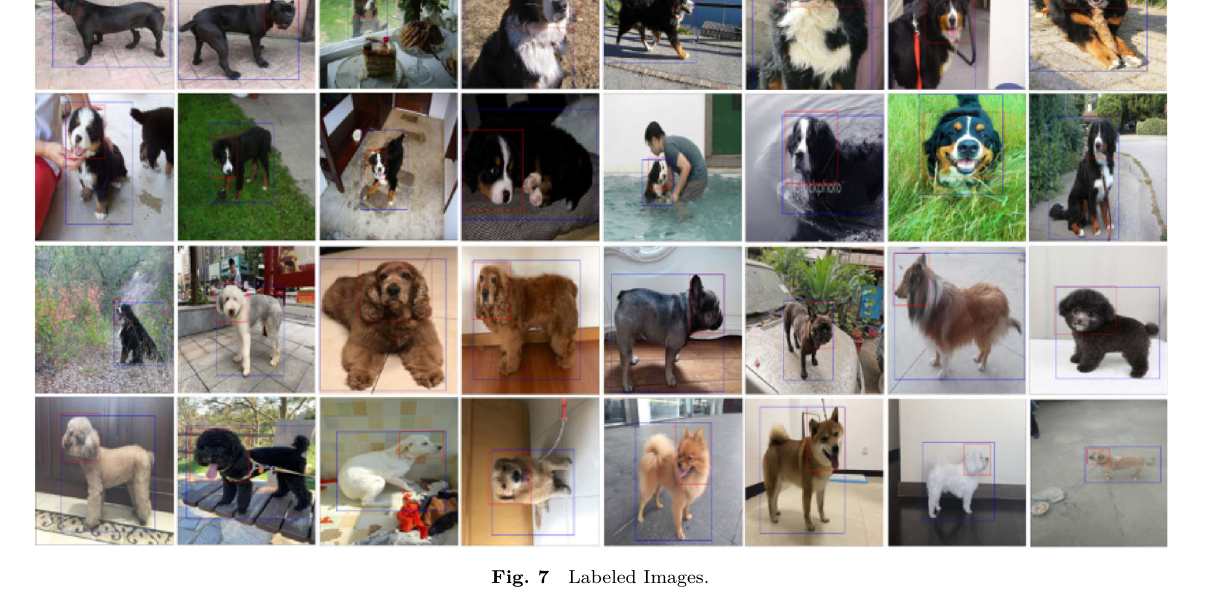
Fig. 7 Labeled Images.